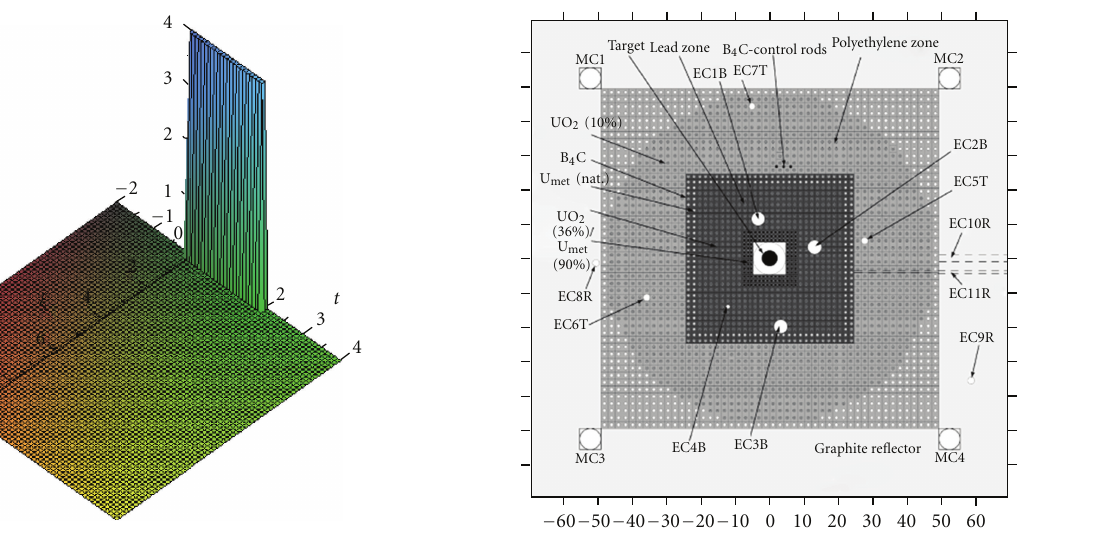
Figure 1: Illustrative sketch of the external neutron source used for the one-group analysis.